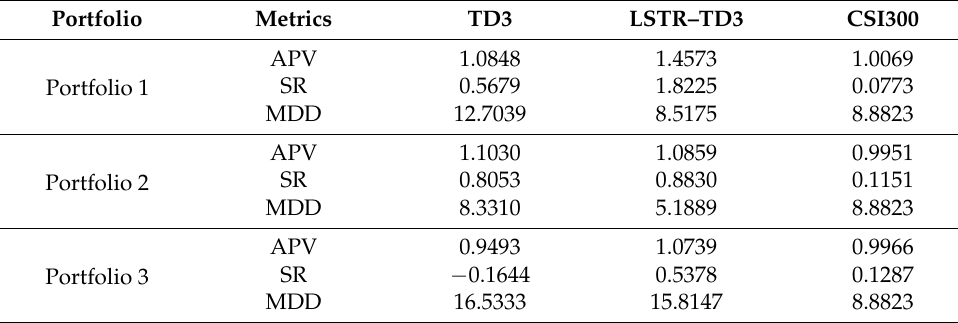
Table 3. Experimental results for three different